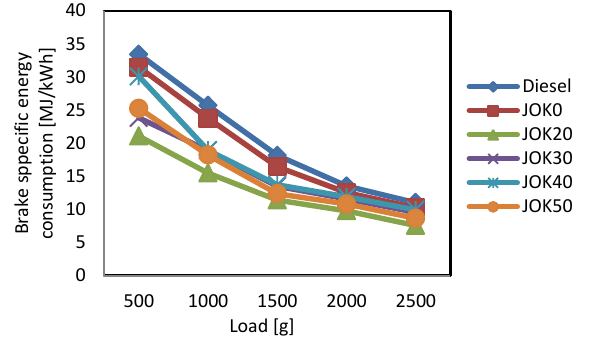
Fig. 5. Variation of BSEC for JOK blends with increase in load